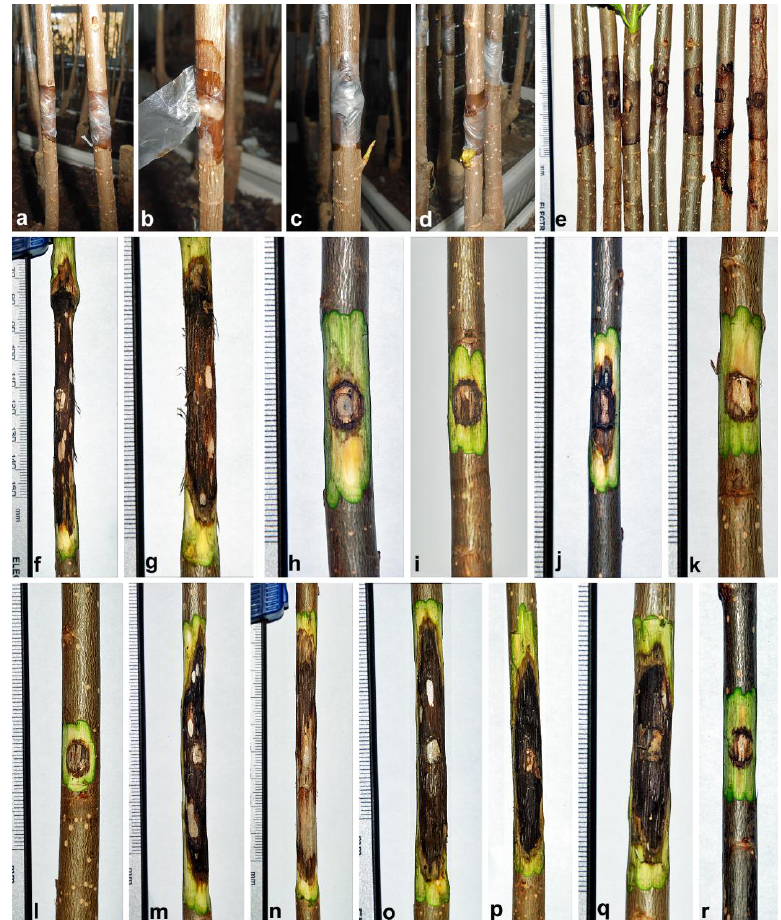
Figure 4. Representative symptoms caused by seven Phytophthora spp. on cuttings of poplar clone I-214 in the underbark inoculation test: ( a , d ) bleeding bark lesions after eight weeks: ( a , b ) P. pini ; ( c ) P. cactorum, with beginning formation of secondary shoot; ( d ) P. plurivora , with beginning formation of secondary shoot; ( e ) cuttings inoculated with P. pini (KF234655) after 11 weeks; ( f , r ) necrotic lesions of the inner bark after 11 weeks: ( f , g ) P. cactorum ; ( h ) P. × cambivora ; ( i ) P. gonapodyides ; ( j ) P. lacustris ; ( k ) P. polonica JX276065; ( l ) P. polonica KF234760; ( m ) P. pini KF234658; ( n ) P. pini KF234655; ( o , p ) P. plurivora KF234740; ( q ) P. plurivora KF234737; ( r )